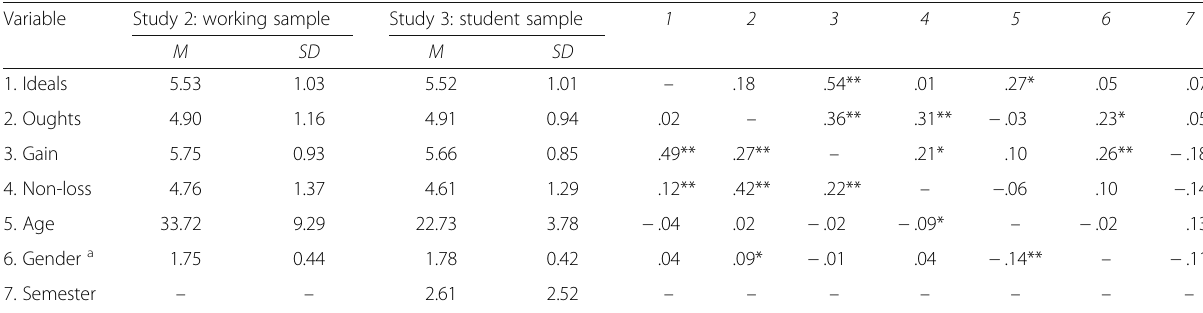
Table 3 Descriptive statistics and intercorrelations of chronic RF and demographic variables (studies 2 and 3)